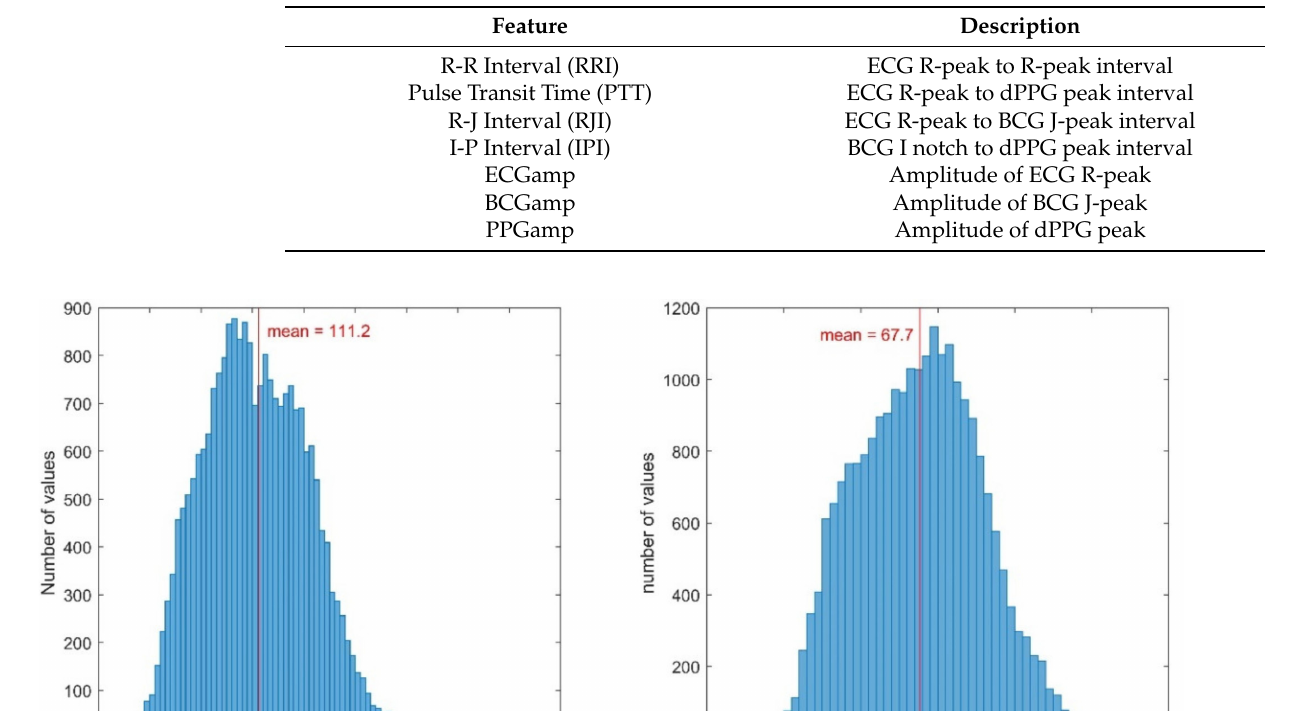
Table 1. List of features used as inputs in our model.